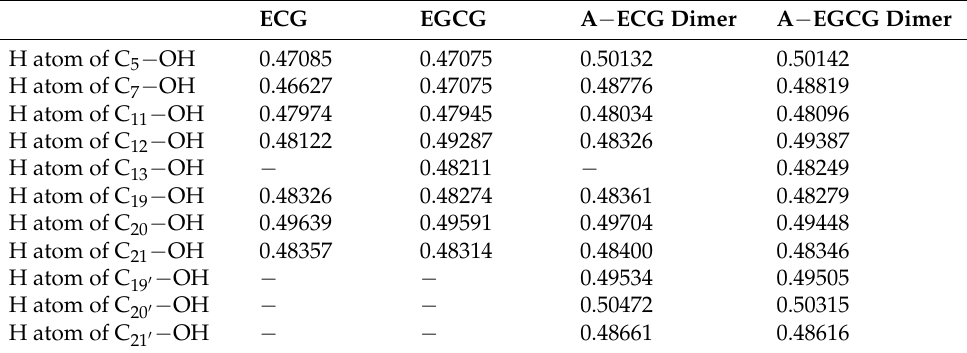
Table 3. The NBO charge on the hydrogen atoms of phenolic hydroxyl groups (e).